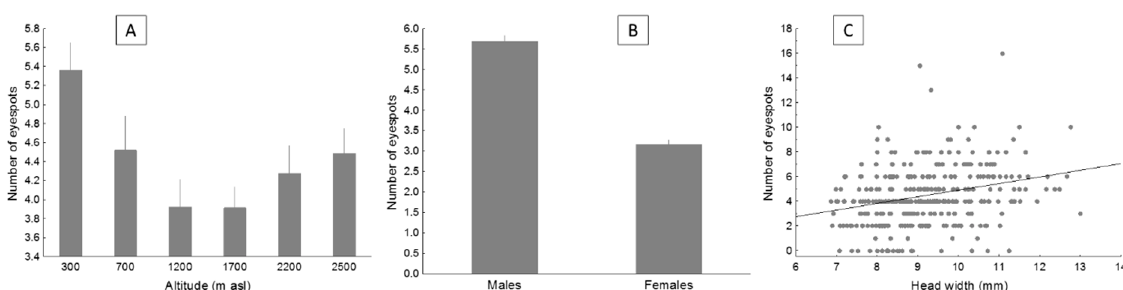
Figure 3. The average number of eyespots (with SE) in the flanks of the lizard P. algirus , according to altitude ( A ) and sex ( B ), and the relationship between the number of eyespots and head width ( C ). Notice that raw data are shown, but statistical analyses were performed with transformed data when necessary. Table 3. Models chosen by model selection approach based on AIC. In bold, predictors with a significant effect. Dependent Variable Predictors df AICc ∆ AIC Weight Eyespots